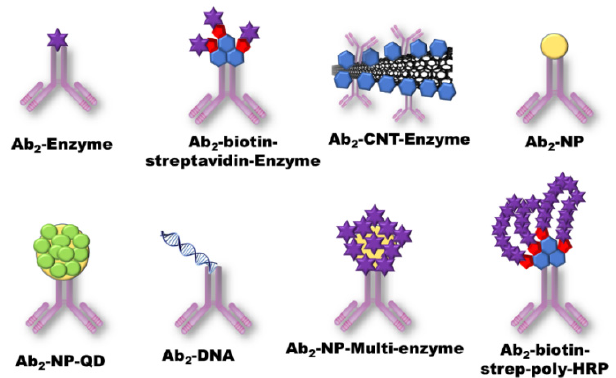
Figure 3. Di ff erent labels conjugated with the secondary antibody (Ab 2 ) during electro immunoassays performed on printed electrodes.